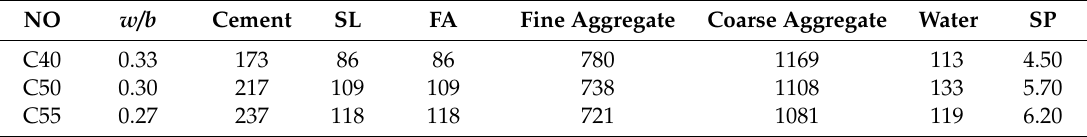
Table 2. Mix proportions of architectural concrete (kg / m 3